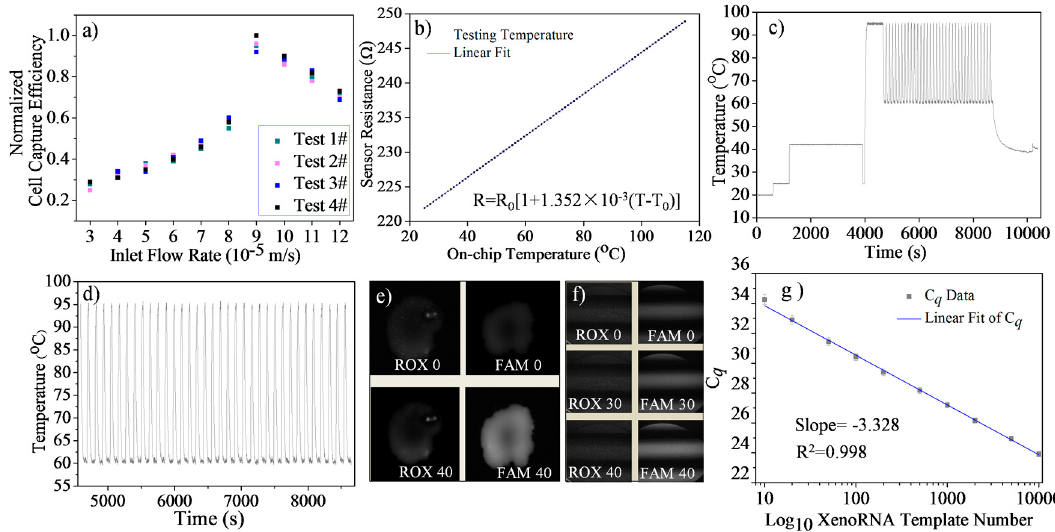
Figure 3. ( a ) Cell trapping efficiency with different inlet flow rate; ( b ) Temperature